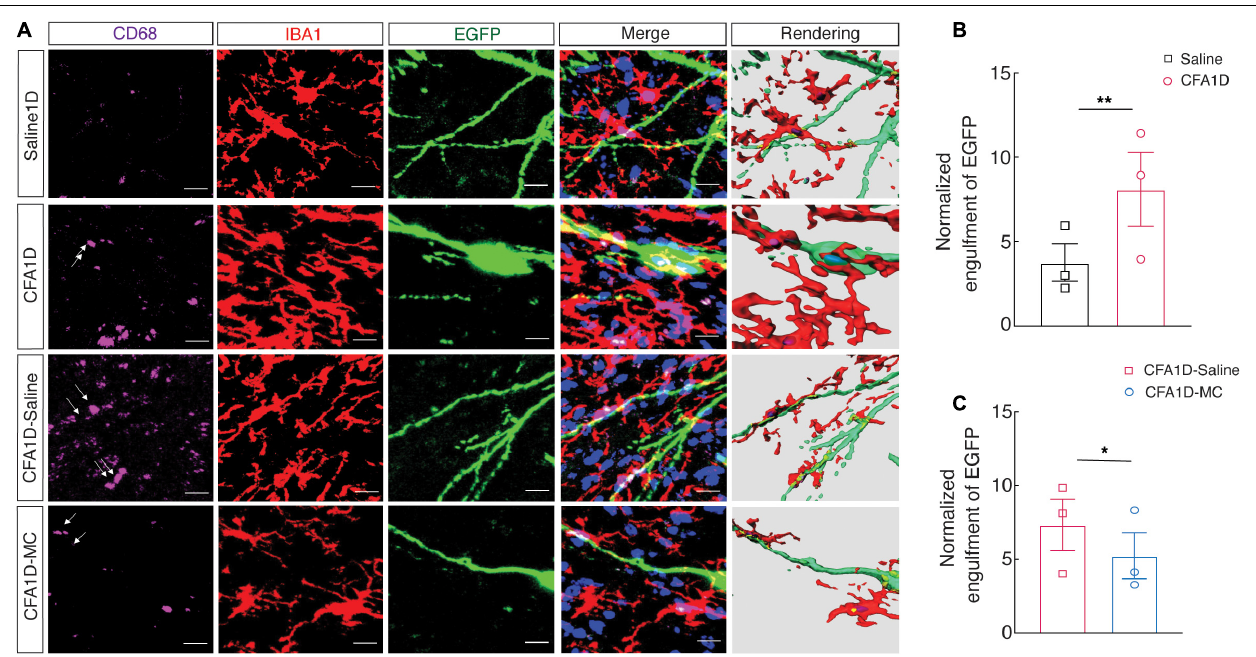
FIGURE 7 | The interactions of the microglial processes and dendritic spines of ZI VGABA . (A) Representative immunofluorescence images and 3D rendering of CD68 (purple), Iba-1 (red), and EGFP (green) of AAV-sparse-CSSP-YFP-8E3 virus into ZI V in the indicated groups. (B) Quantification of EGFP + dendritic spines (green) containing Iba-1 + microglia (red) in the ZI V from CFA1D and saline mice ( t 10 = 3.21 and P = 0.0093). (C) Quantification of EGFP + dendritic spines (green) Iba-1 + microglia (red) in the ZI V from saline and minocycline treatment of CFA1D mice ( t 10 = 3.117 and P = 0.0109). Scale bars, 10 µ m. Unpaired t -test. * P < 0.05 and ** P < 0.01; ns, not significant.